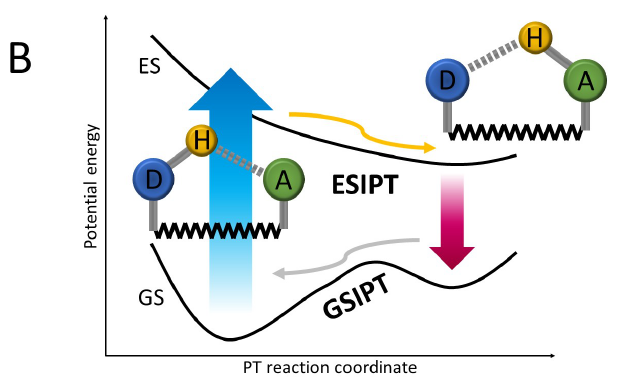
Figure 1. Schematic representation of the ESIPT mechanism: ( A ) initial atomic arrangement of an ESIPT system; ( B ) typical (most basic) potential energy landscape along the ESIPT reaction coordinate. D—proton donor; A—proton acceptor; GS—ground electronic state; ES—excited electronic state; blue arrow—initial photoabsorption; red arrow—Stokes-shifted